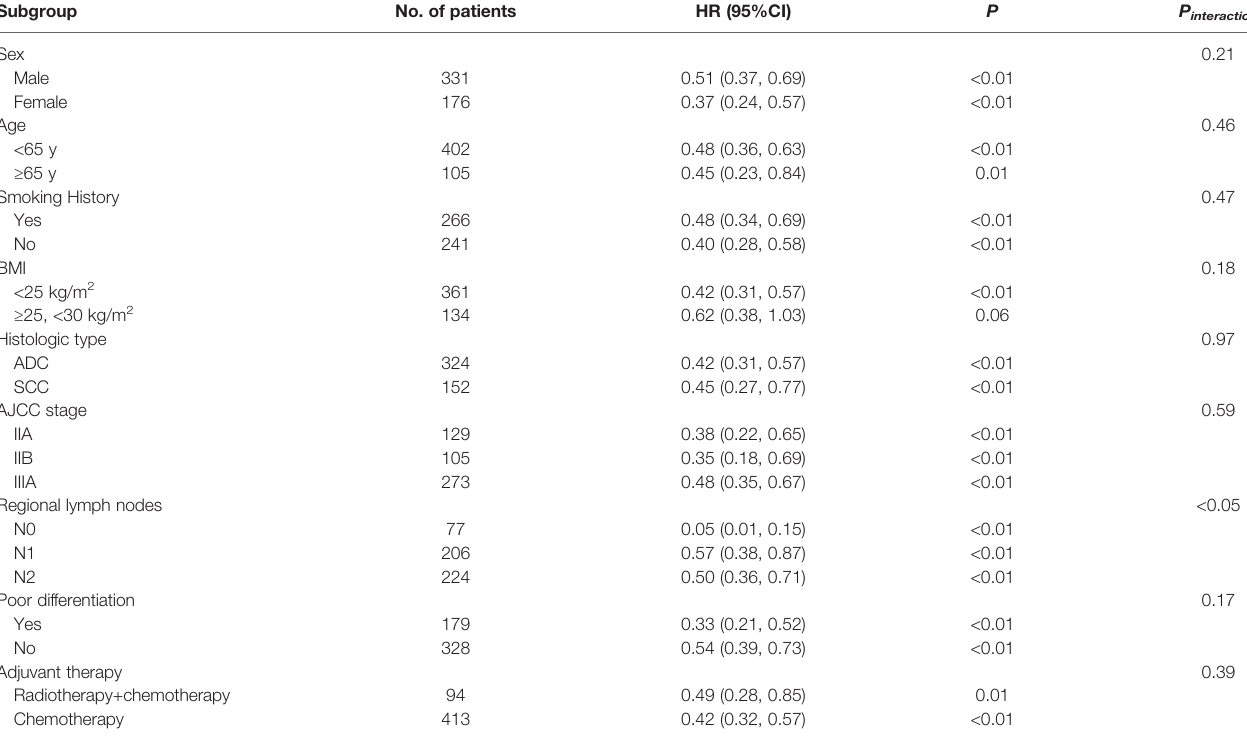
TABLE 2 | Subgroup Analysis of Disease-free Survival. Subgroup No. of patients P